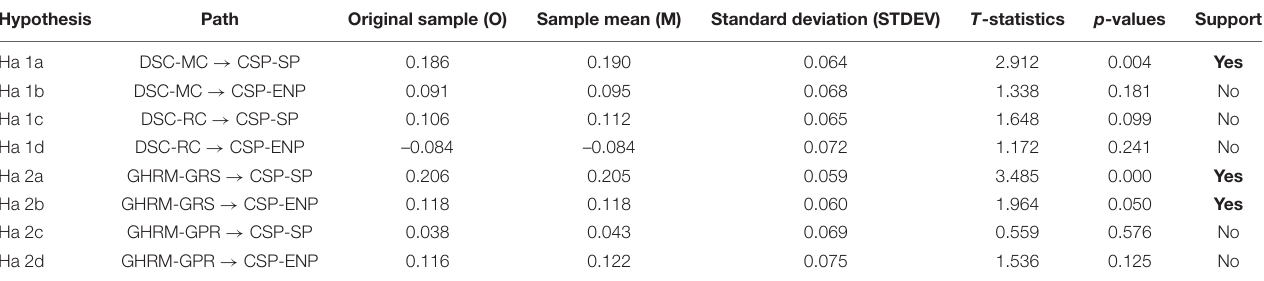
TABLE 10 | Path analysis of the sub-hypotheses.